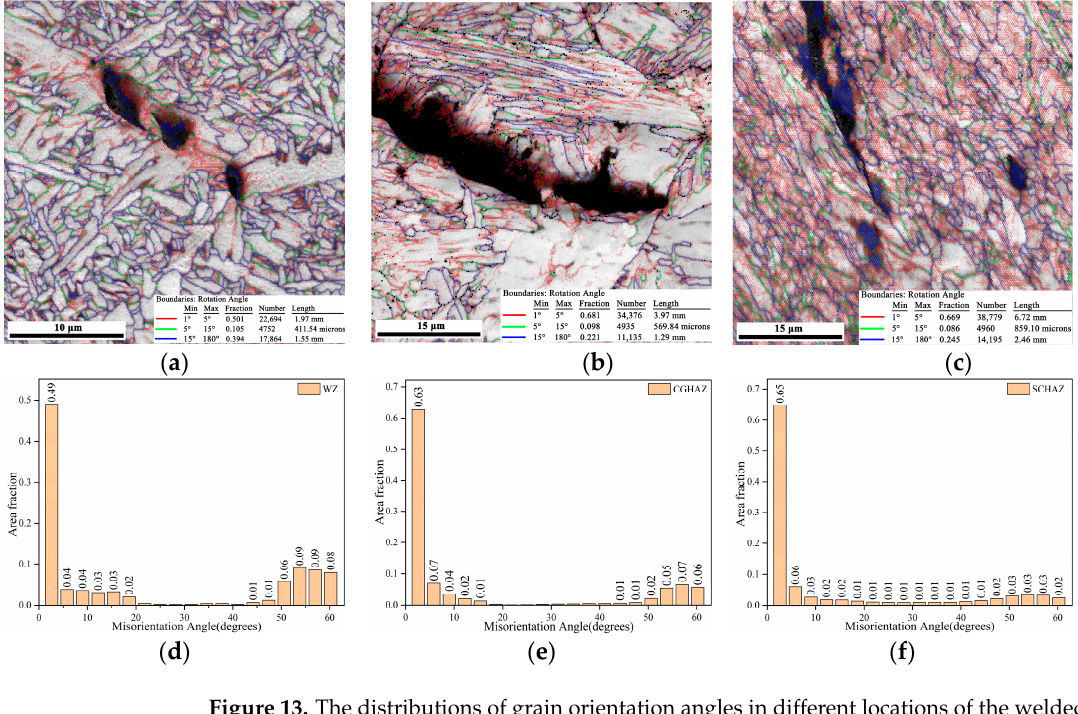
Figure 13. The distributions of grain orientation angles in different locations of the welded joint: ( a , d ) WM; ( b , e ) CGHAZ; ( c , f ) SCHAZ.